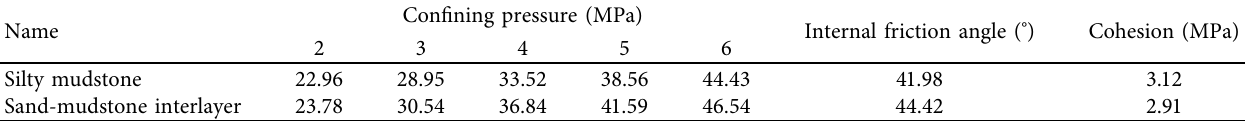
Table 3: Triaxial compression test results of remoulded specimens under different confining pressure.